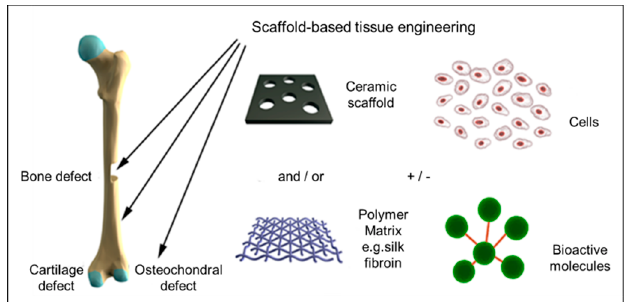
Figure 1. Schematic diagram of skeletal tissue regeneration via scaffold-based tissue engineering strategies. The tissue engineering triad can be concluded as using a combination of cells, growth factors, and scaffolds. Adapted with permission from [22].